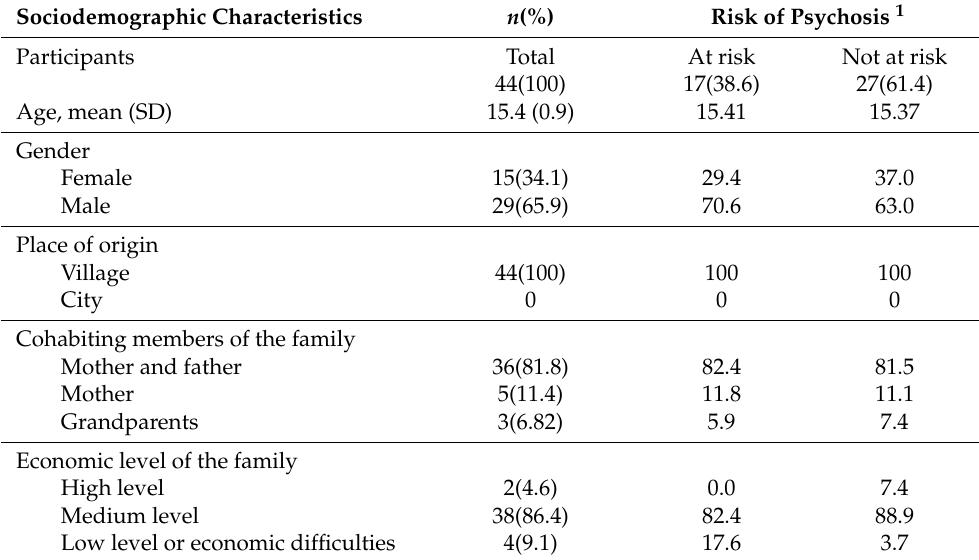
Table 1. Sociodemographic characteristics according to the risk of psychosis of the study participants. Sociodemographic